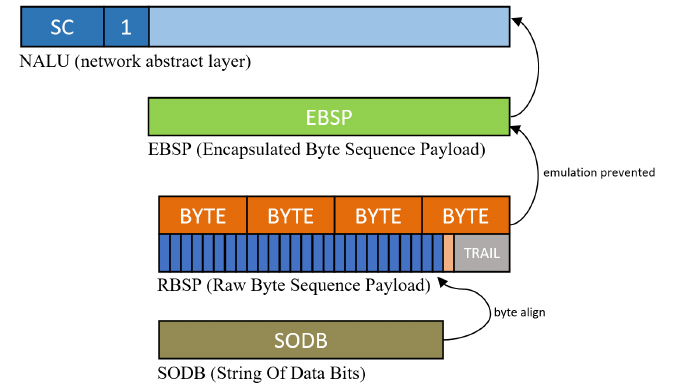
Figure 4. Example of NAL Unit in H.264